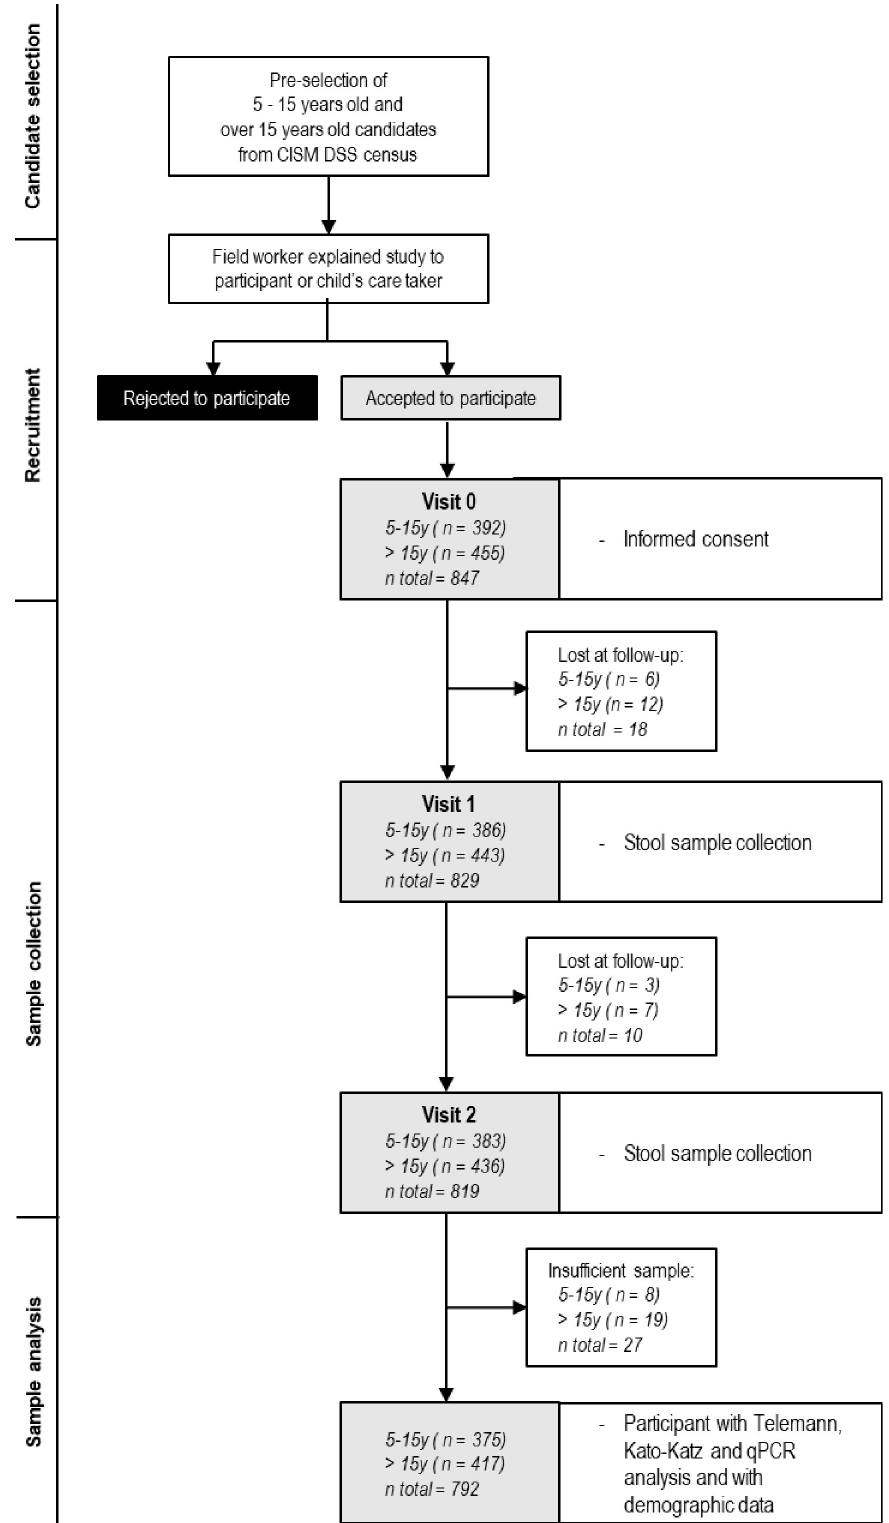
Fig 1. Diagram flow of recruitment of 5 to 15 years old participants and over 15 years old participants and their sample collection and analysis.